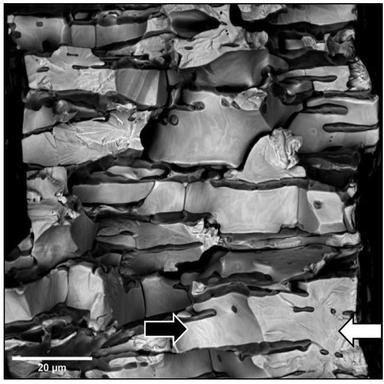
SEM backscattered electron image of R87 TD-ND fracture surface. Transgranular W fracture is marked with a white arrow, and intergranular cracking is marked with a black arrow. For interpretation of the references to color in this figure legend, the reader is referred to the web version of this article.